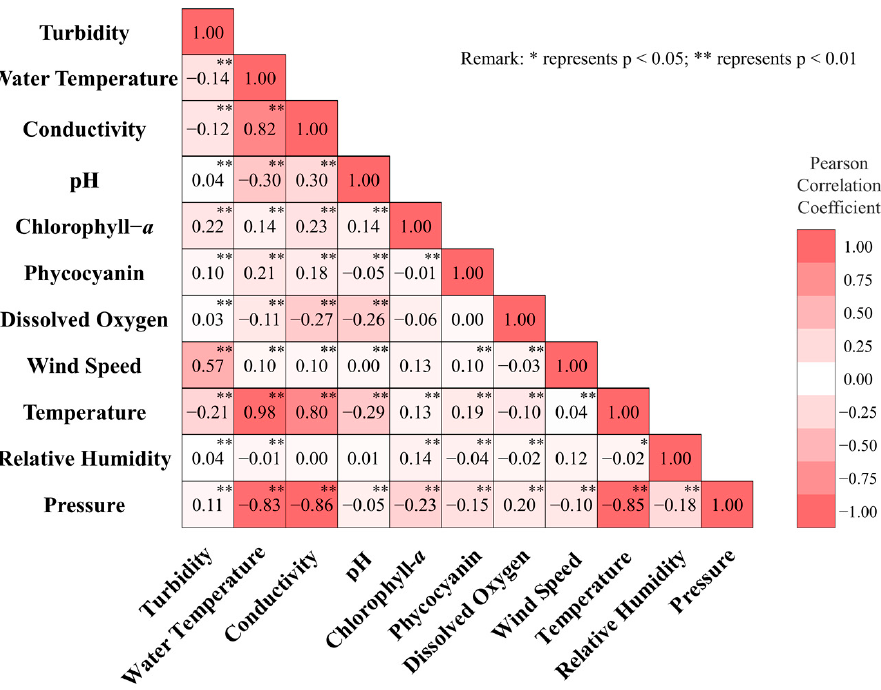
Figure 4. Pearson’s correlation coefficients between different environmental variables measured at S2.